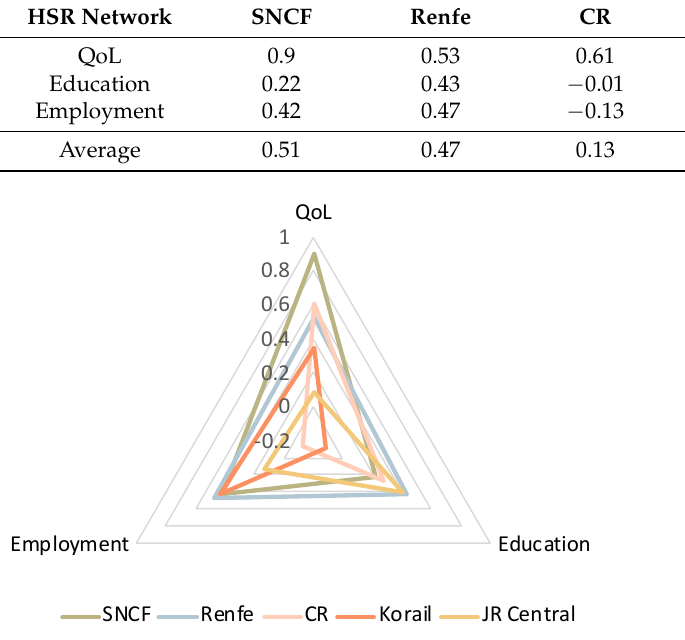
Figure 8. The summarisation of three pillars by networks.